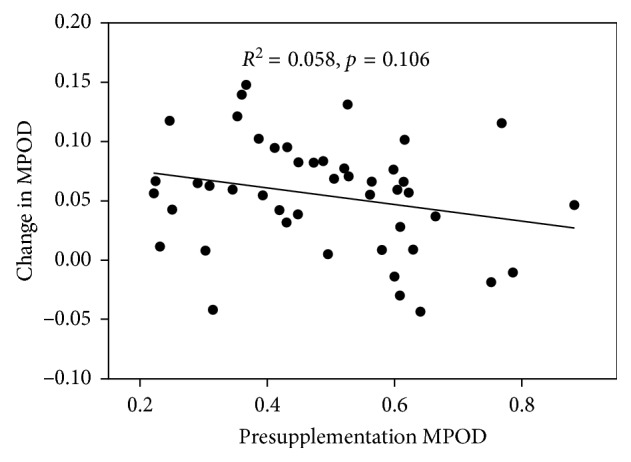
Change in MPOD as a function of presupplementation MPOD for all 46 subjects (23 taking 20 mg per day (equivalent free carotenoids) of diacetate esters of lutein, zeaxanthin, and mesozeaxanthin in a 10 : 10 : 2 ratio and 23 taking lutein).